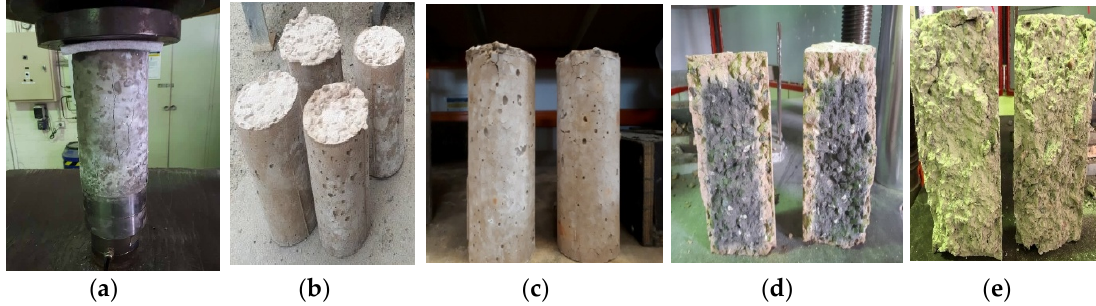
Figure 13. The effect of high temperatures on mix samples at ( a , b ) 600 ˚C and ( c – e ) 900 ˚C.